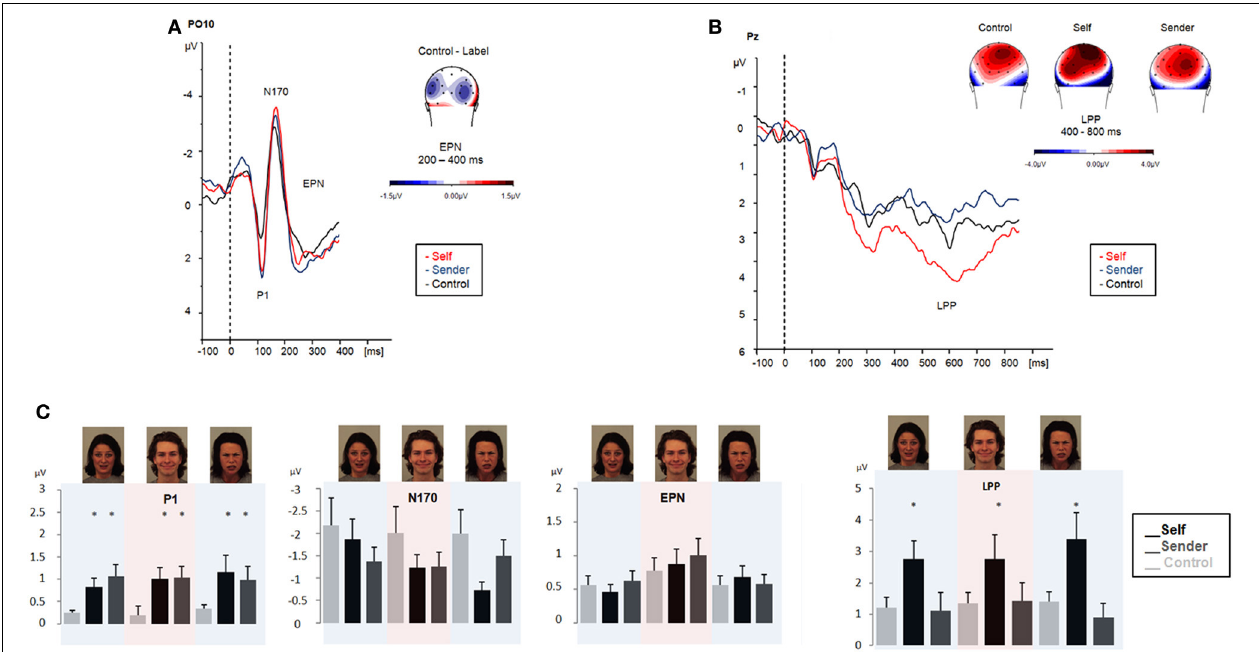
LPP. Maps display the topographic distribution of the ERPs in µ V. Lower panel (C) overview of P1, N170, EPN and LPP modulation (means and SEMs) during emotional face processing in experiment 2. Color shadings highlight ERP modulation for each emotional category (fearful, angry, and happy).